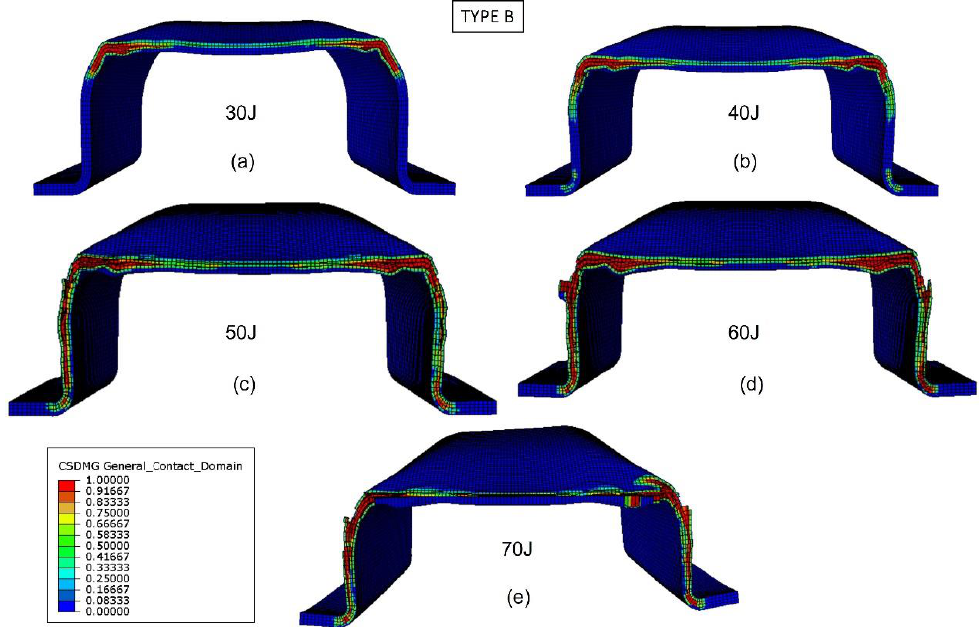
Figure 14. Delamination initiation criterion at the middle cross section of bumper beam Type B.